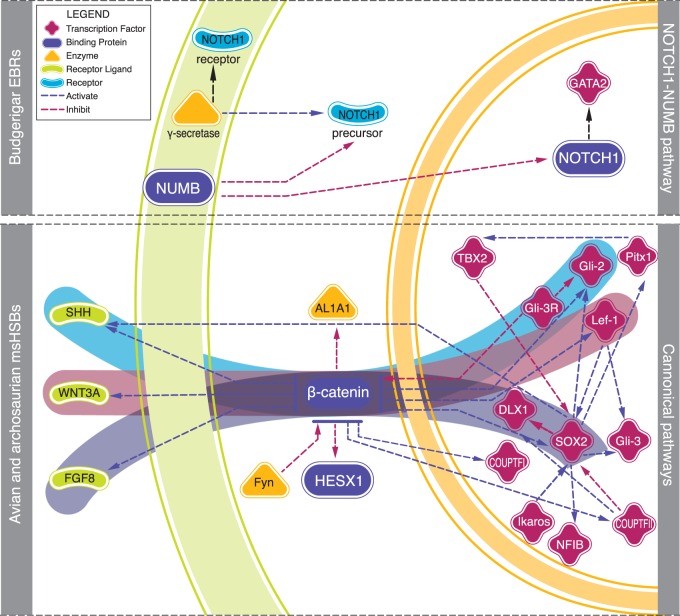
Gene pathways related to forebrain development in budgerigar lineage-specific EBRs and avian and archosaurian msHSBs. Budgerigar lineage-specific EBRs (top box) are enriched for genes related to the NOTCH1-NUMB pathway, while avian and archosaurian msHSBs (bottom box) for genes related to three conserved canonical pathways (SHH pathway in blue, WNT3 pathway in pink and FGF8 pathway in purple). The function of each protein is indicated in the legend by different shapes and colours. Red lines connecting two proteins indicate inhibition, while blue lines show activation. The green circular shade represents the cell membrane, while the orange circular shade demarcates the nuclear envelope. The image was modified from Metacore version 6.22 build 67265 and Bertrand and Dahmane (2006).